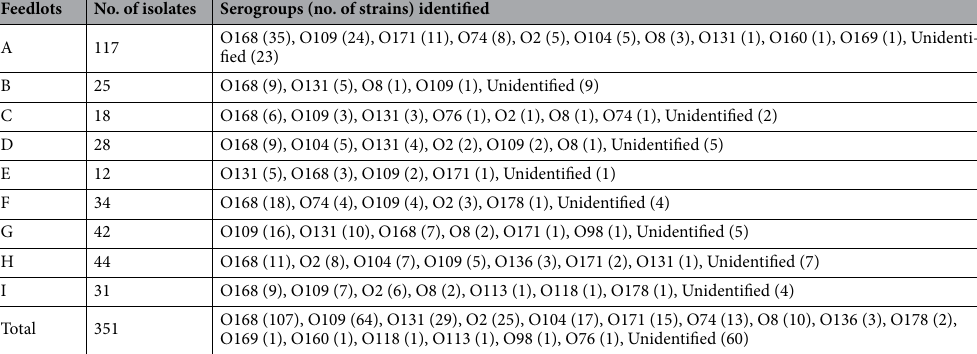
Table 3. Distribution of serogroups and number of strains of Shiga toxin-producing Escherichia coli isolated from feces of cattle collected from nine feedlots.